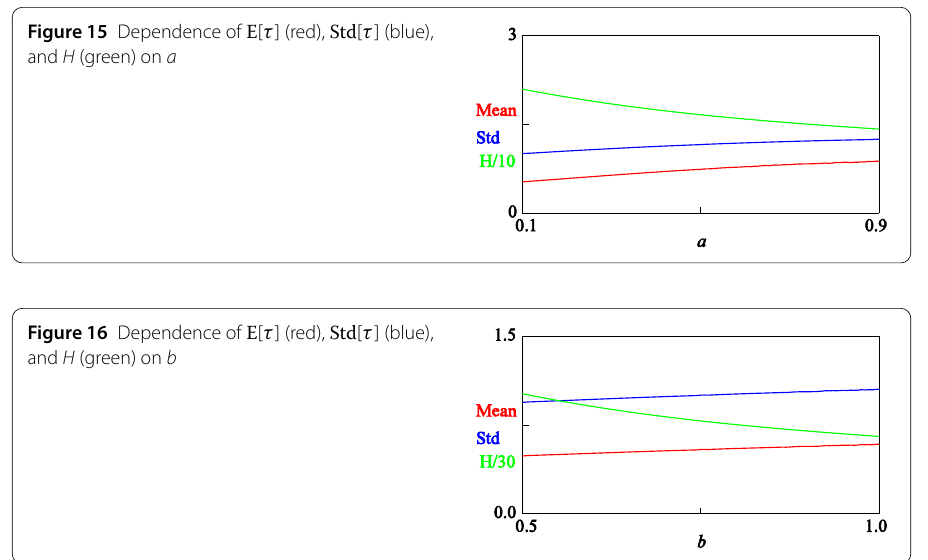
Figure 16 Dependence of E [ τ ] (red), Std [ τ ] (blue), and H (green) on